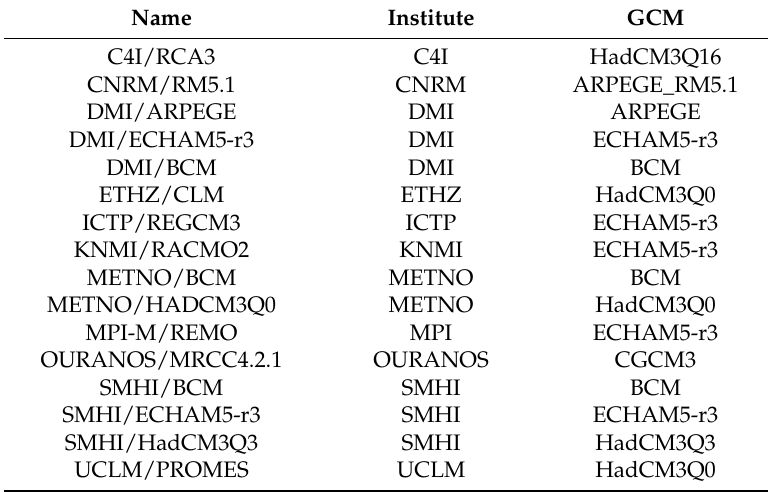
Table 1. Selected the regional climate models (RCMs) from ENSEMBLES project.